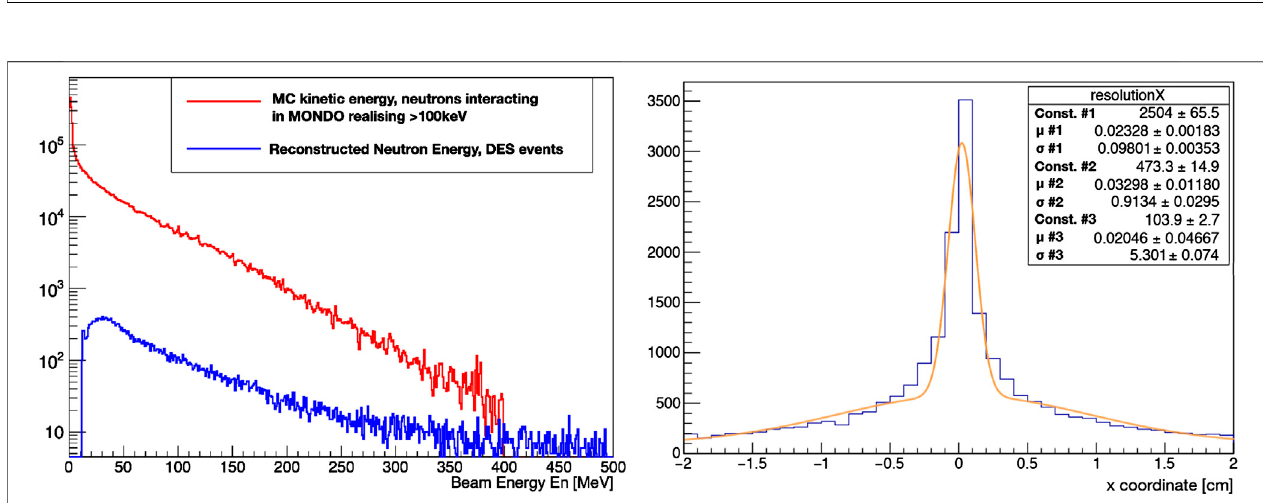
FIGURE 3 | (Left) Two-dimensional reconstructed emission point at 20cm from MONDO detector. The distribution is symmetric for both x and y planes. (Right) Back-pointing resolution for the X-projection as a function of the neutron kinetic energy. Emission point at 20cm from MONDO detector is assumed. The resolutions obtained from MC truth proton energy and direction are also shown. The error bars correspond to the statistical contribution in the back-pointing resolution measurement.